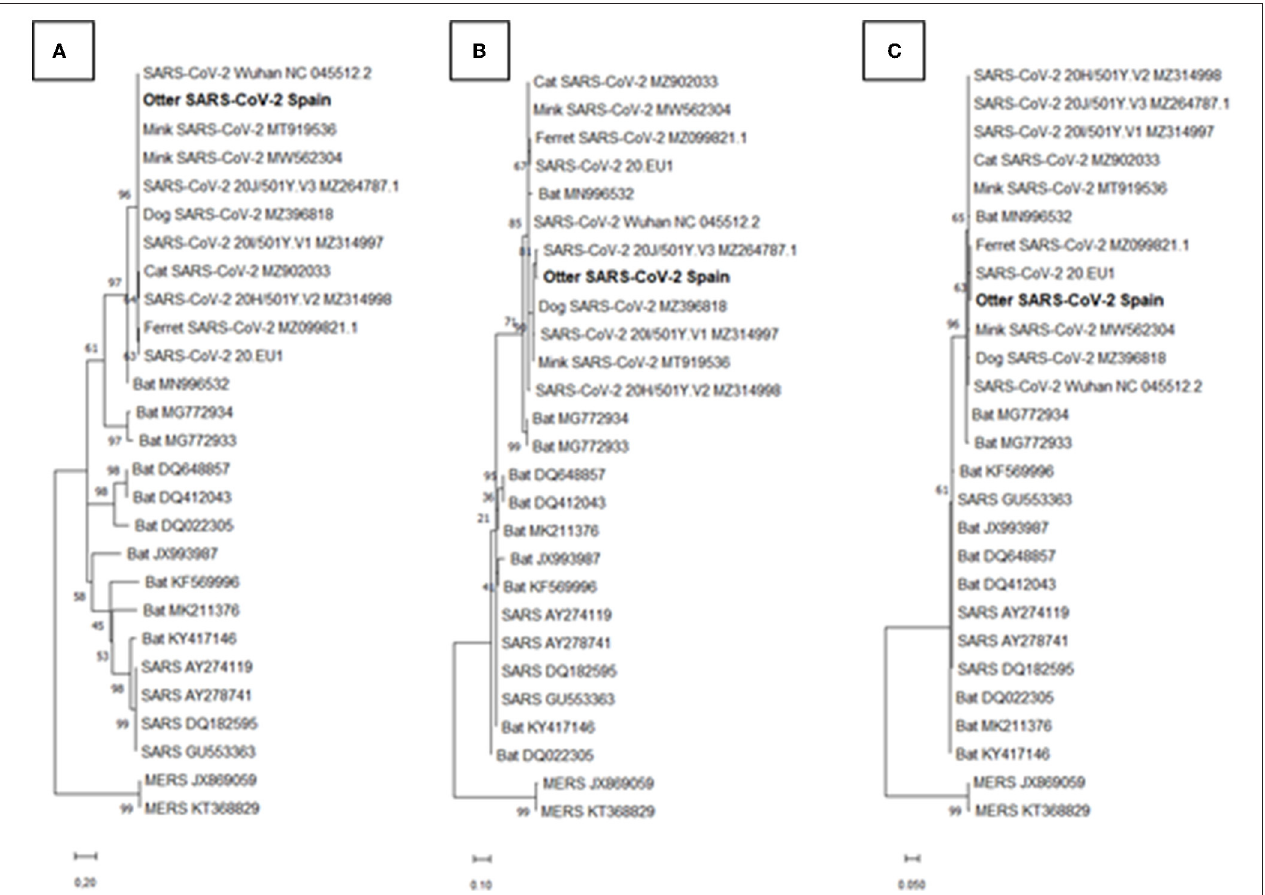
FIGURE 2 | Molecular phylogenetic analyses based on partial gene sequences. These analyses used our sequences of 80-, 94-, and 149-nucleotide fragments of the severe acute respiratory syndrome coronavirus 2 (SARS-CoV-2) S gene (A) , N gene (B) , and ORF10 gene (C) (respective consensus genome coordinates; GenBank acc number NC_045512.2, nt 22,160–22,239, 28,871–28,964, and 29,556–29,704). The trees include the corresponding sequences in SARS-CoV (SARS), Middle East respiratory syndrome coronavirus (MERS-CoV) (MERS), some bat coronaviral sequences, and SARS-CoV-2 sequences reported in animals or in the original Wuhan isolate and a few subsequent variants. The evolutionary history was inferred using the maximum likelihood method based on the Tamura–Nei model. In each case, the tree with the highest log likelihood ( − 722, − 377.01, and − 446.87, for trees of S , N , and ORF10 genes, respectively) is shown. Initial tree(s) for the heuristic search were obtained automatically by applying the neighbor-join and BioNJ algorithms to a matrix of pairwise distance estimated using the maximum composite likelihood (MCL) approach and selecting the topology with superior log likelihood value. The trees are drawn to scale, with branch lengths according to the number of substitutions per site (see scale bar at the bottom). The sequences obtained from the Eurasian otter reported here is highlighted in bold-type. GenBank accession numbers for the different sequences are given at the end of each branch name. GenBank accession numbers for our otter viral sequences are OK235485, OK235486, and OK235487 for the S , N , and ORF10 genes,